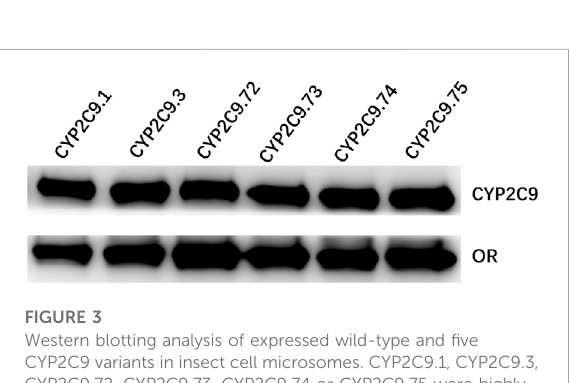
FIGURE 3 Western blotting analysis of expressed wild-type and fi ve CYP2C9 variants in insect cell microsomes. CYP2C9.1, CYP2C9.3, CYP2C9.72, CYP2C9.73, CYP2C9.74 or CYP2C9.75 were highly co-expressed with OR in insect cell